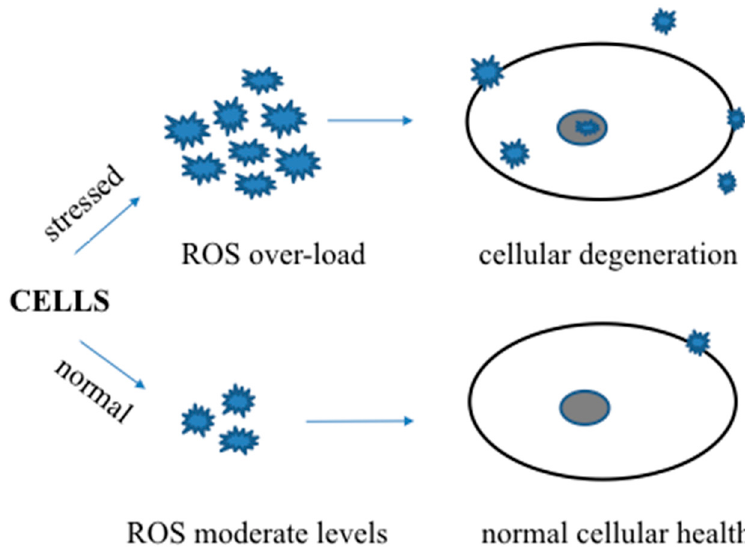
Figure 1. A schematic showing the beneficial and harmful roles of reactive oxygen or nitrogen species in normal and stressed conditions.